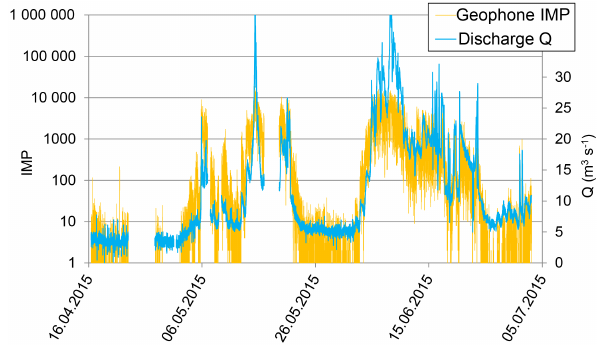
Figure 2. Discharge ( Q ) and number of geophone impulses (IMP G ) summed over the 15 geophone sensors, shown as a time series for the period 16 April until 5 July 2015.